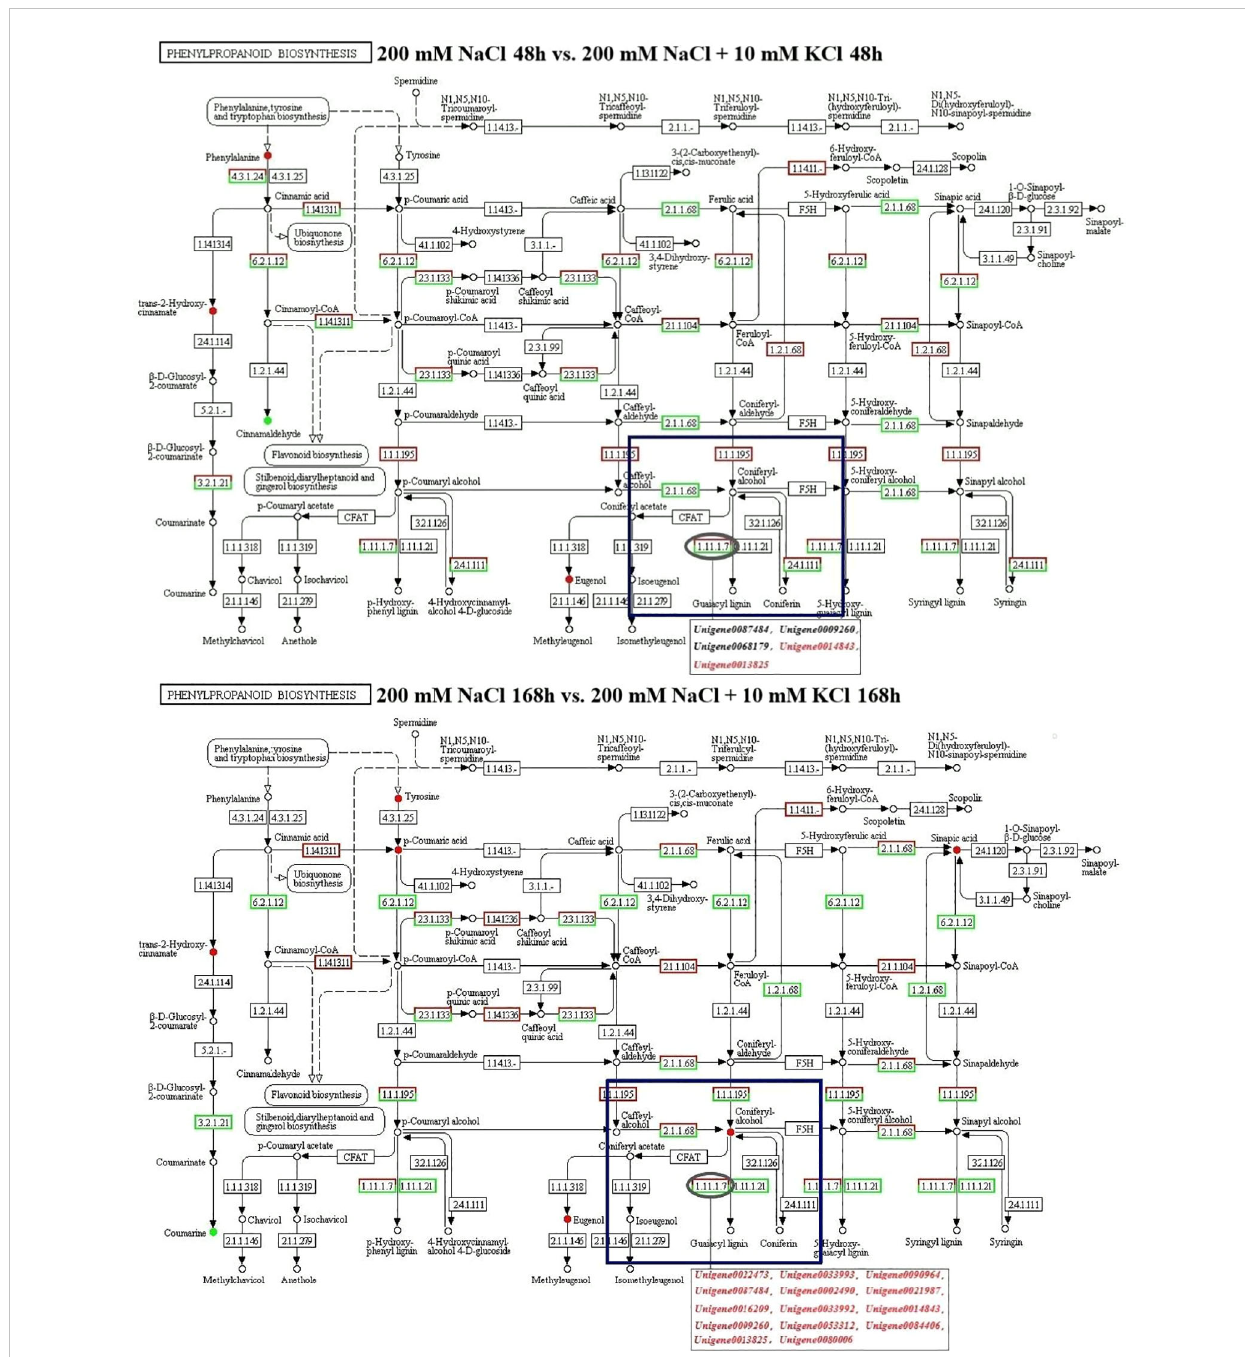
FIGURE 5 Analysis of Phenylpropanoid biosynthesis pathway in the roots of T. ramosissima by exogenous K + application under NaCl stress. (1.11.1.7 in the blue box is the location of POD activity-related DEGs; these DEGs regulate the downstream of coniferyl alcohol; Black genes represent down-regulated genes, and red genes represent up-regulated